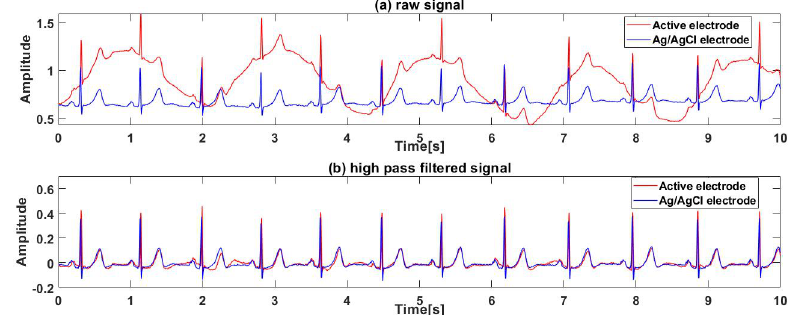
Figure 6. Comparison between signals measured by active electrodes and Ag/AgCl electrodes: ( a ) raw signal, ( b ) high pass filtered signal.